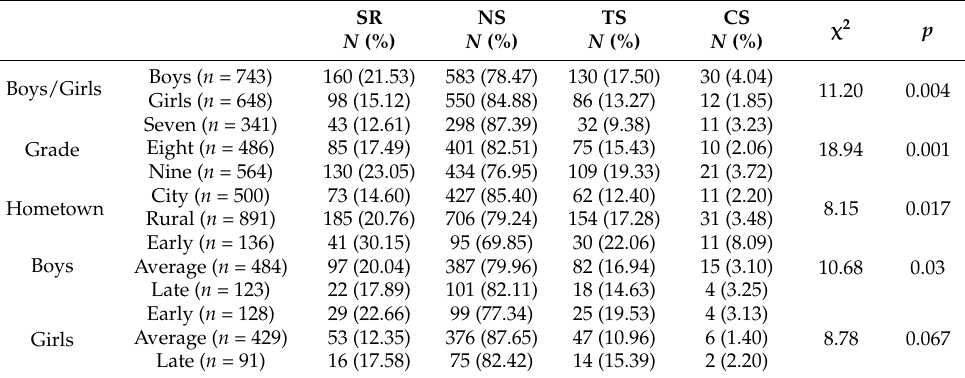
Table 2. Frequency (%) of the characteristics of adolescents by adolescents’ smoking status and results of association ( N = 1391), pubertal timing differences on smoking